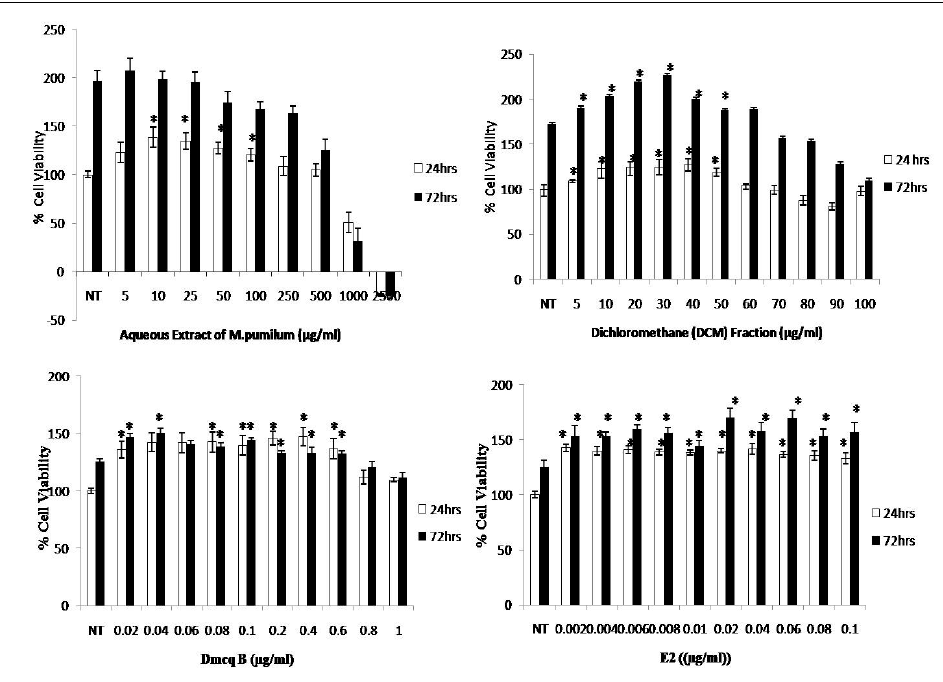
Figure 3. Stimulation effects of M. pumilum var. alata crude aqueous extract, DCM fraction, Dmcq B